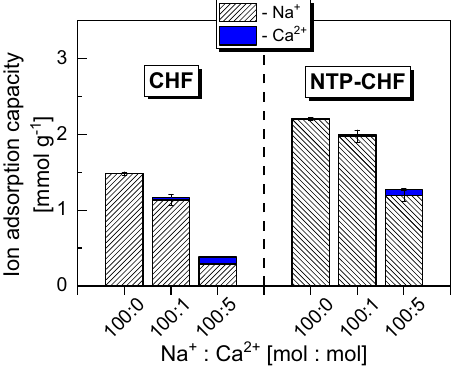
Fig. 7 Changes in cation adsorption capacities during repeated adsorption and desorption cycles in the presence of 0.43 mM of Ca 2 + in 8.6 mM of Na + (Na + :Ca 2 + = 100:5).